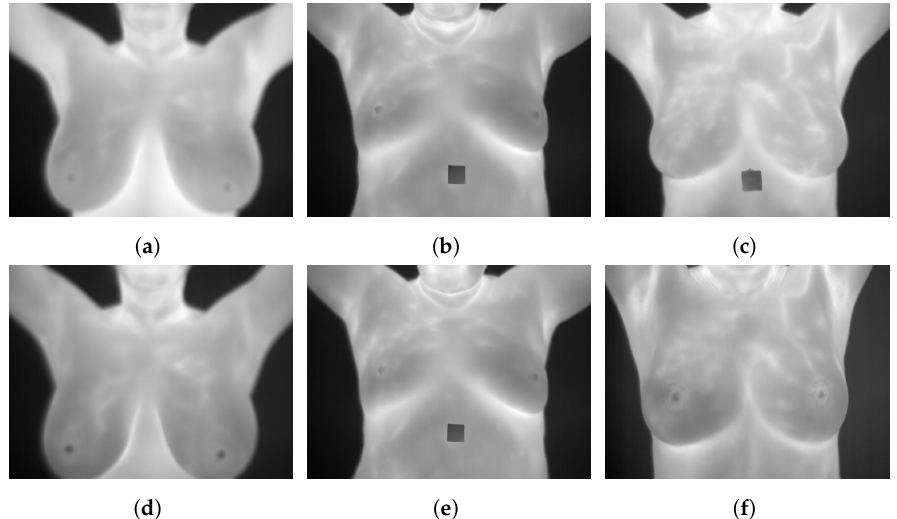
Figure 4. Sample images from the DMR-Database ( a ): static frontal healthy; ( b ): static frontal sick; ( c ): static frontal unknown; ( d ): dynamic frontal healthy; ( e ): dynamic frontal sick; ( f ): dynamic frontal